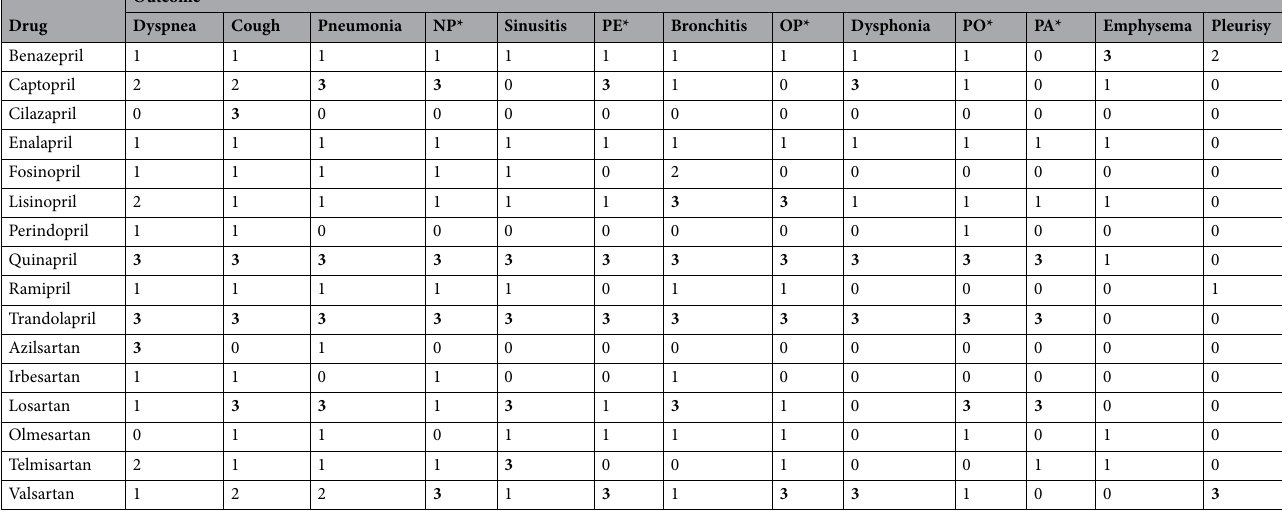
Table 2. ADEs (flagged bold) meeting criteria for reporting. Numbers in the table indicate how many criteria of these three are met: criteria (1) more than 3 occurrences, criteria (2) a PRR > 2, and criteria (3) a PRR that is > than the lower 95% confidence interval boundary with the lower confidence interval being greater than one 18 . ADEs meeting all three criteria are flagged bold. * NP nasopharyngitis, PE pleural effusion, OP oropharyngeal pain, PO pulmonary edema, PA pneumonia aspiration.